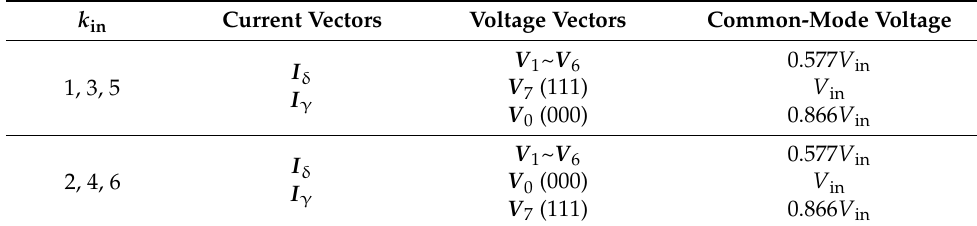
Table 1. Common-mode voltage under different vectors.